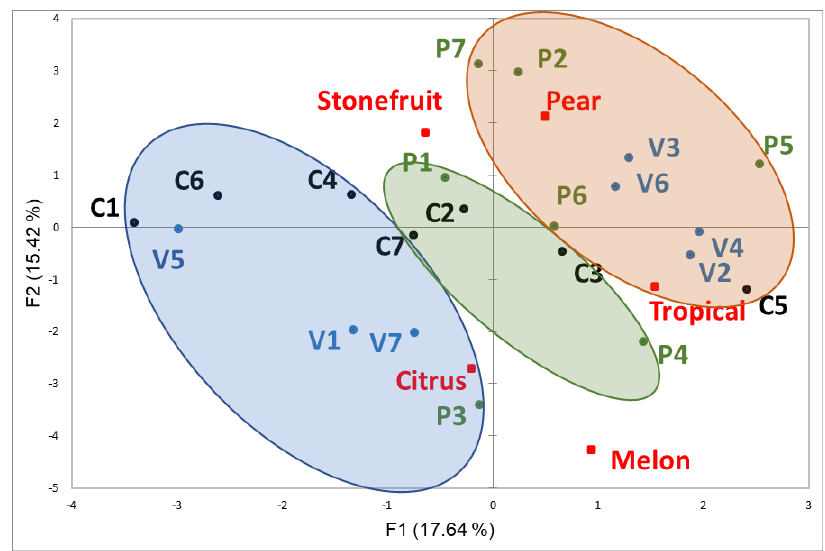
Figure 2. MFA plot showing wine experts’ PPM results for first and second factors. Ellipses identify groups according to k-means clustering. Varietal wines are shown in different colors.